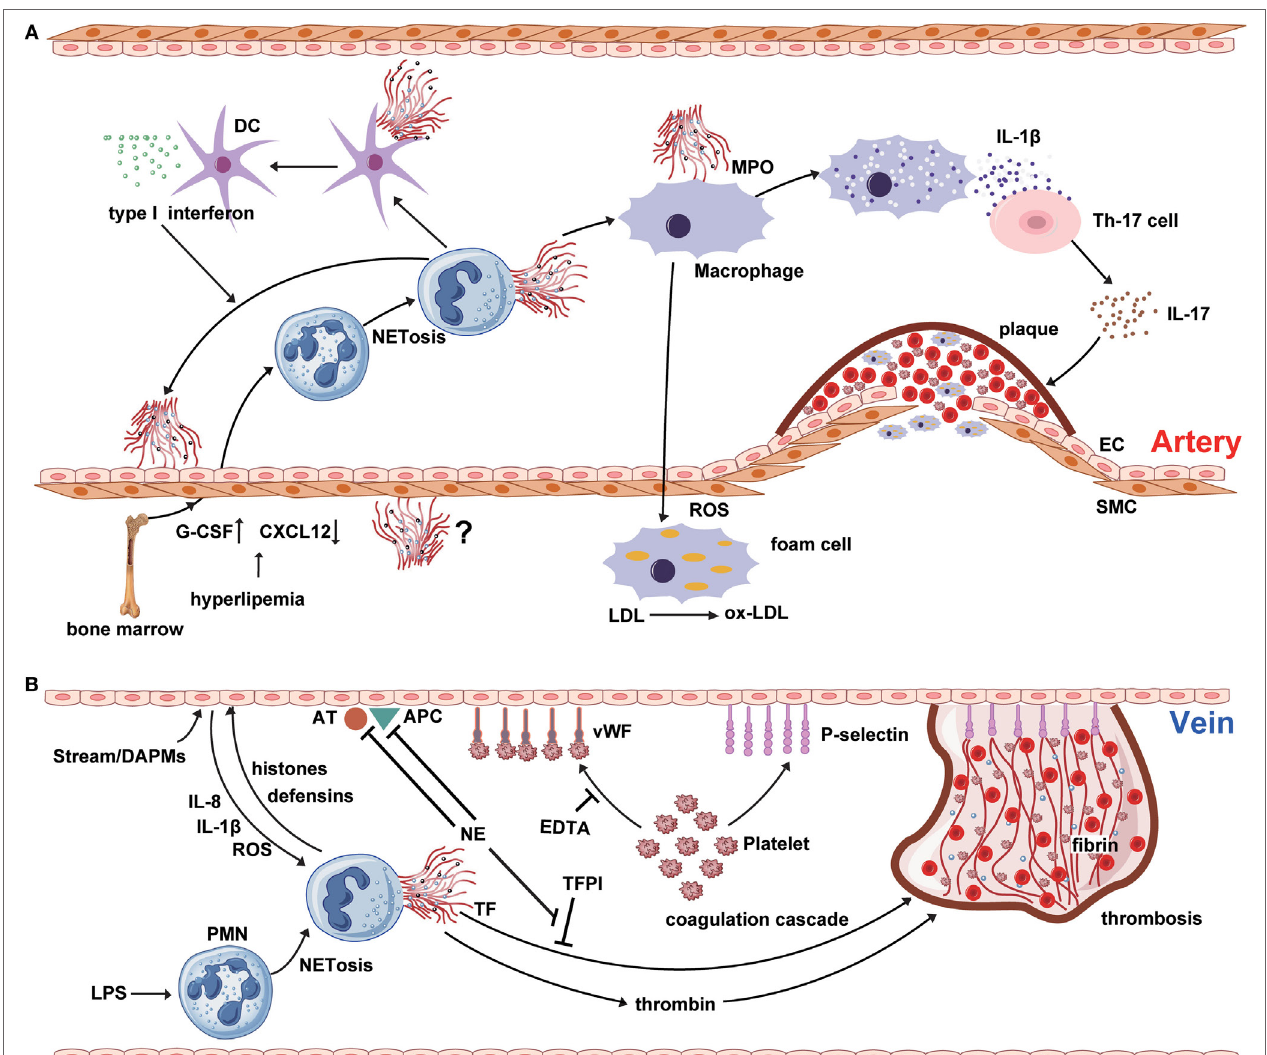
FiGURe 1 | NETosis interweaves atherosclerosis and thrombosis. (A) Neutrophil extracellular traps (NETs) are involved in the whole process of atherosclerosis. The myeloperoxidase from NTEs can stimulate macrophage to oxidize low-density lipoprotein (LDL) to ox-LDL and form the foam cell. The hyperlipidemia recruits neutrophil into circulation from bone marrow by upregulating the expression of granulocyte colony-stimulating factor and downregulating the level of C-X-C motif ligand -12, which is an important signal for the clearance and recruitment of aged neutrophils to the bone marrow. Cholesterol crystals can trigger the polymorphonuclear neutrophil (PMN) to release the NETs that prime the macrophages for pro-inflammatory cytokine production including IL-1 β . Then IL-1 β activates Th17 cell to release interleukin-17, amplifying the immune cell recruitment into the atherosclerotic plaque. As another critical source of foam cell, SMC also takes part in atherosclerosis. However, there are few reports about the interaction between NETs and SMC. (B) NETs are released from PMNs, which are activated by LPS or other cytokines from injured endothelial cells. NETs promote the expression of von Willebrand factor and P-selectin on the surface of venous endothelium to entrap both platelets and red blood cells, thereby creating a scaffold for fibrin deposition. Meanwhile, histones and TF from the NETs structure induce the thrombin generation and activation via platelet-dependent or -independent mechanism. Tissue factor pathway inhibitor (TFPI) can abrogate the function of TF. However, utrophil elastase from NETs could degrade TFPI, antithrombin, and activated protein C